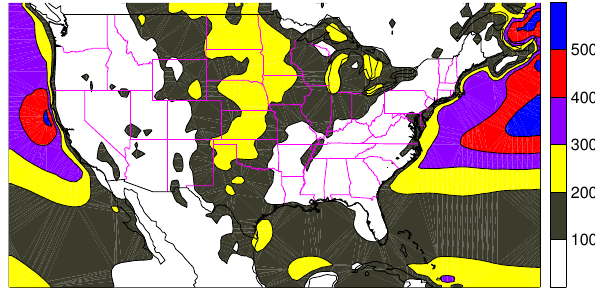
Fig. 3. Geographical variation of median WPD (W m − 2 ) across the US.